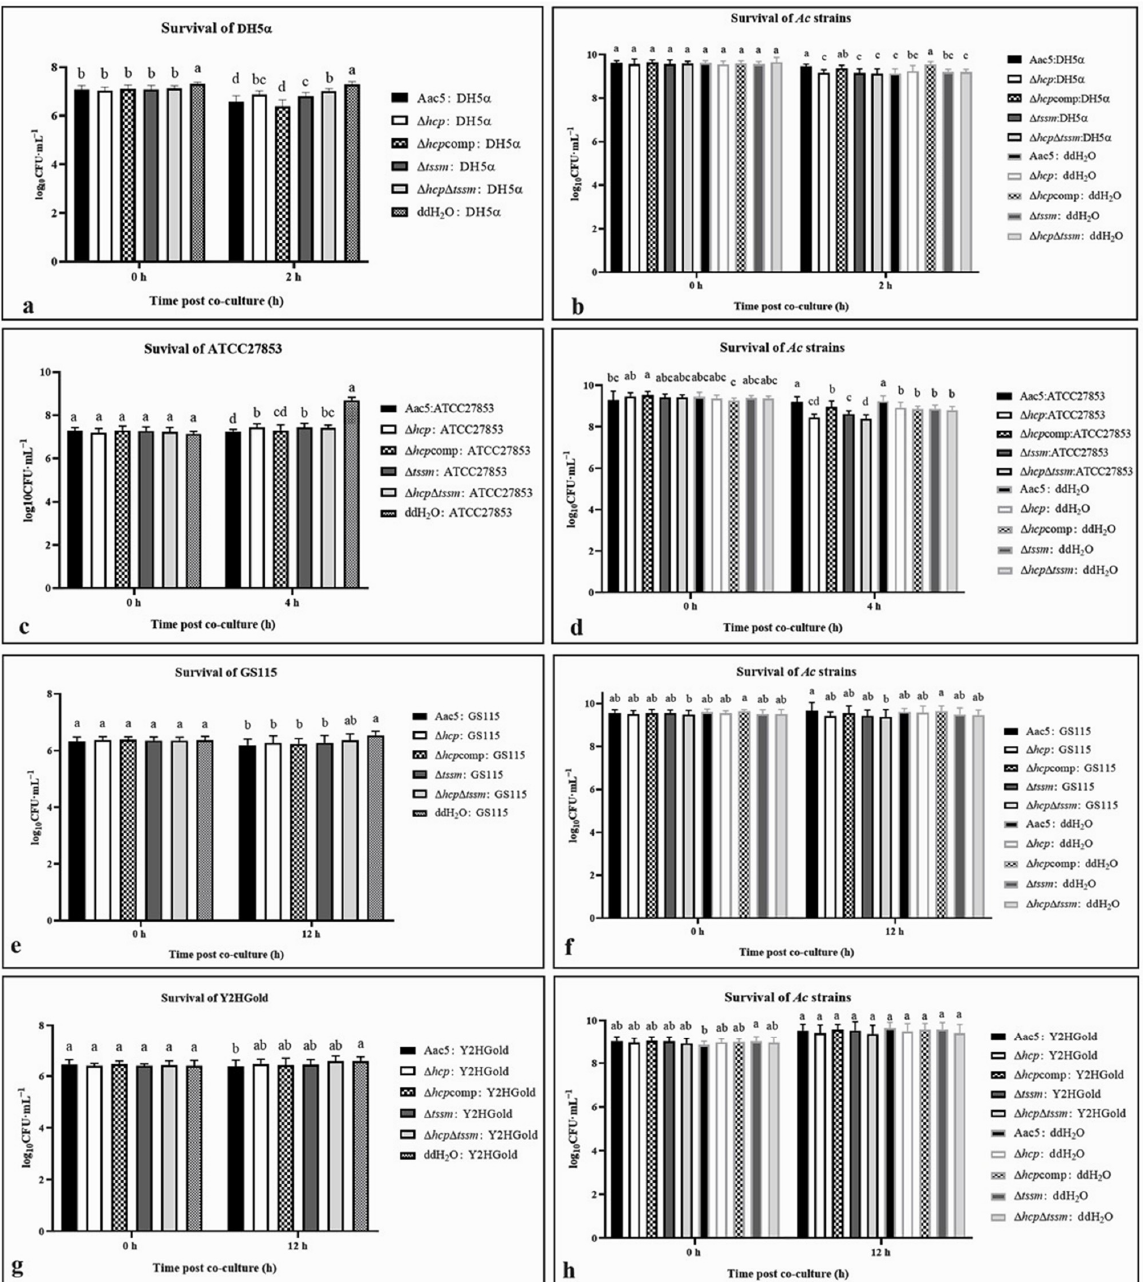
Figure 5. Interspecies competition of Acidovorax citrulli strains ( Ac strains for short) Aac5 (WT), Δ hcp , Δ hcp comp, Δ tssm , and Δ hcp Δ tssm with Escherichia coli DH5 α -pBBRMCS5, Pseudomonas aeruginosa ATCC27853, Saccharomyces cerevisiae Y2HGold, and Pichia pastoris GS115. ( a ) Survival of E . coli DH5 α -pBBRMCS5 on LB amended with gentamicin (Gm) after 2 h of co-culture with A. citrulli killer strains (Aac5, Δ hcp , Δ hcp comp, Δ tssm , and Δ hcp Δ tssm ) at a killer:prey ratio of 20:1. ( b ) Survival of Aac5, ∆ hcp , ∆ hcp comp, ∆ tssm , and ∆ hcp ∆ tssm strains on KB amended with Amp and Km after 2 h of